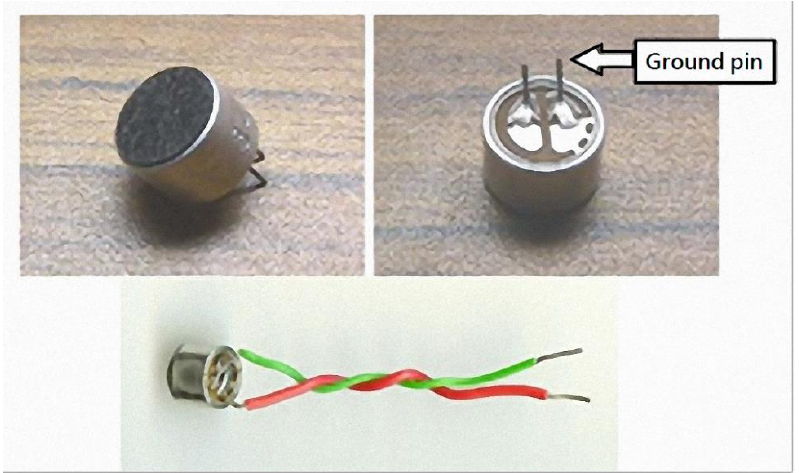
Figure 7. Condenser microphone